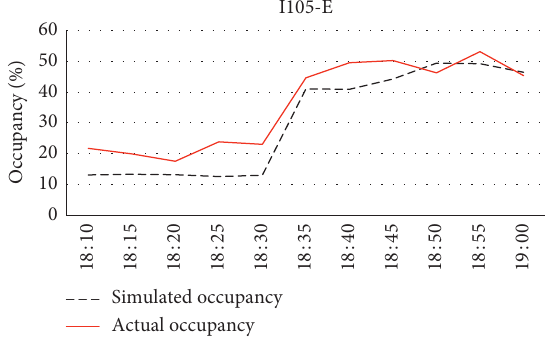
Figure 8: Actual and simulated occupancy comparison at freeway